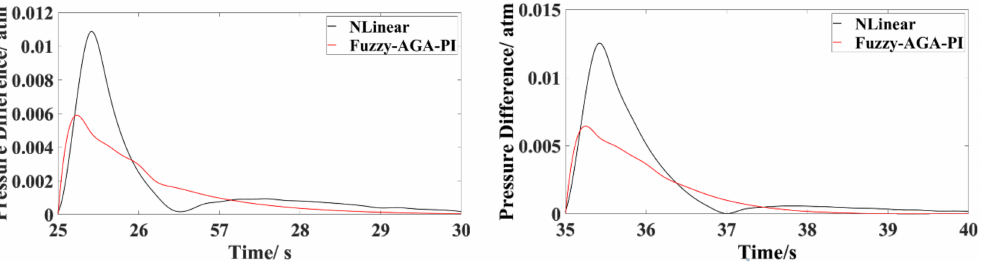
Figure 9. Two load changing moments with slight changes in the load.